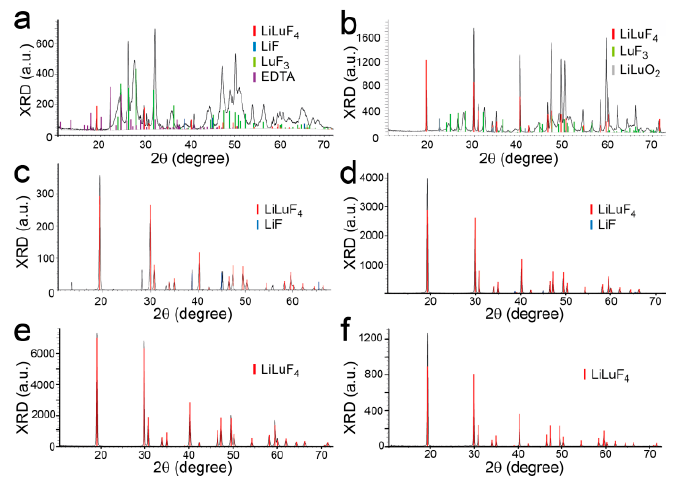
Figure 4. Powder XRD pattern of crystals following PEG-assisted hydrothermal synthesis at: ( a ) 100 ◦ C, ( b ) 120 ◦ C, ( c ) 130 ◦ C, ( d ) 150 ◦ C, ( e ) 180 ◦ C, and ( f ) 200 ◦ C, for 24